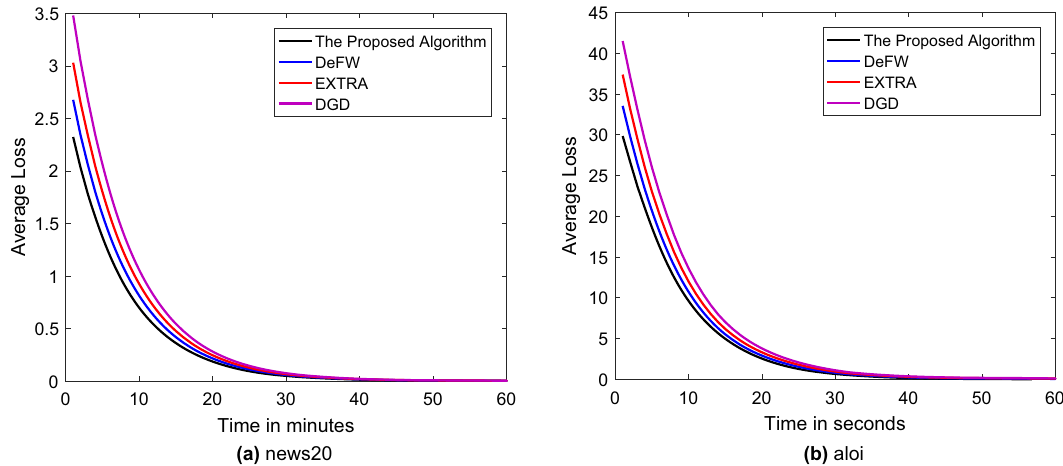
Fig. 1 Comparison of the proposed algorithm, DeFW, EXTRA, and DGD for the convex problem on news20 and aloi datasets